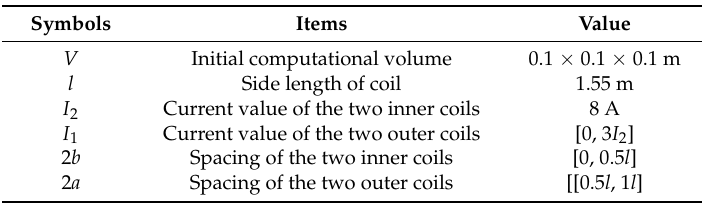
Table 2. The values parameters and the range of